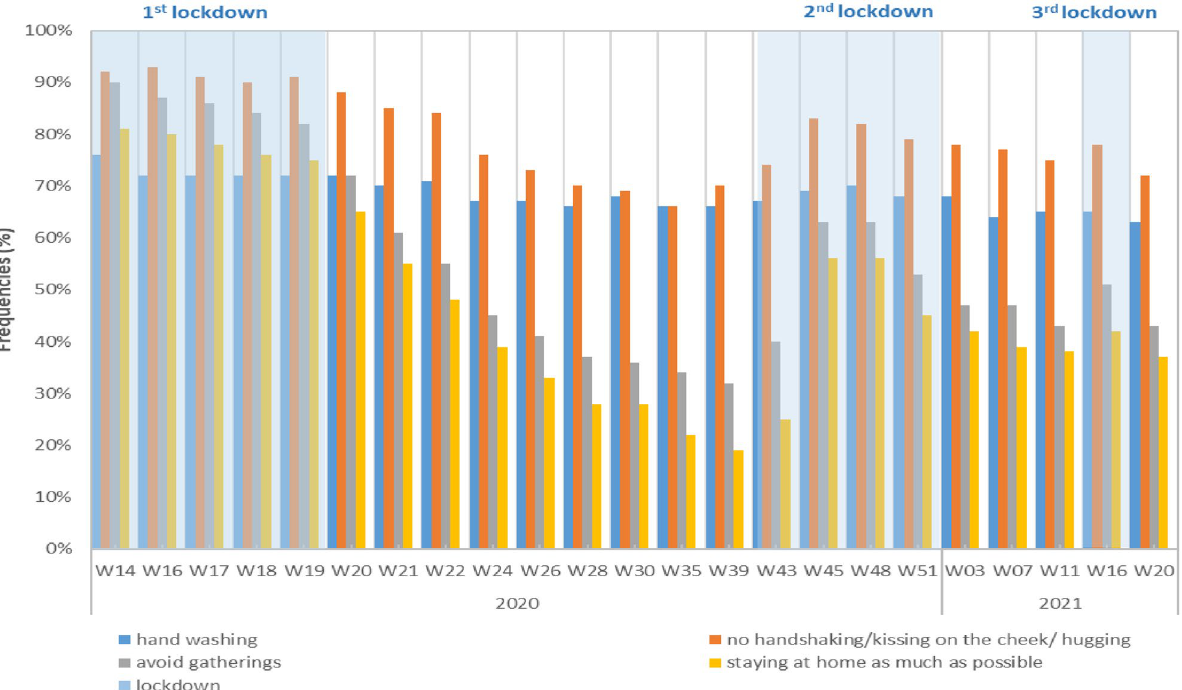
Figure 4. Frequencies of systematic adherence to barrier measures against SARS-CoV-2, CoviPrev survey, metropolitan France, week 14–2020 to week 20–2021 (only weeks with data are displayed). Light blue boxes: nationwide